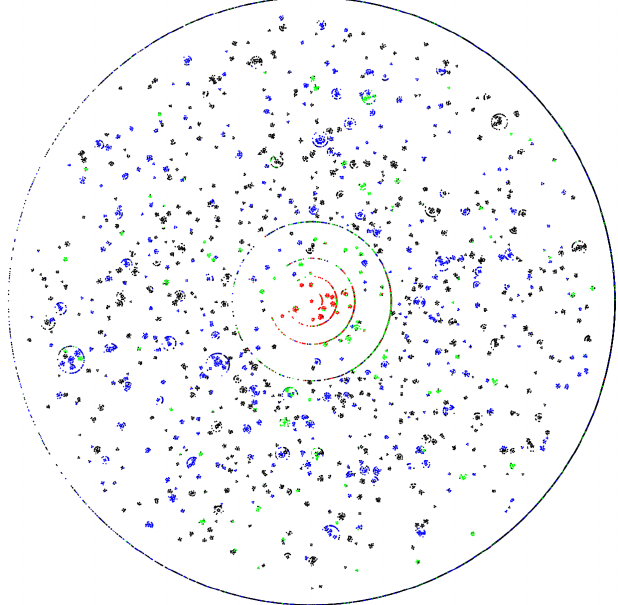
FIG. 8. A network of 50000 nodes, with a power-law degree distribution with γ ¼ 3 . 1 and a clustering spectrum ¯ c ð k Þ ¼ 0 . 25 . The nodes are distributed according to the m -core decomposition. Red nodes (1811) are the core because they belong to the giant component after we perform a bond percolation with p ¼ 0 . 2 (between the two percolation thresholds). Blue and green nodes are peripheral nodes that belong to the giant component at p ¼ 0 . 5 (just after the second percolation threshold). Once we subtract the core, blue nodes (10408) still remain in the GC; meanwhile, green nodes (4271) belong to small components. Black nodes (33510) never belong to the